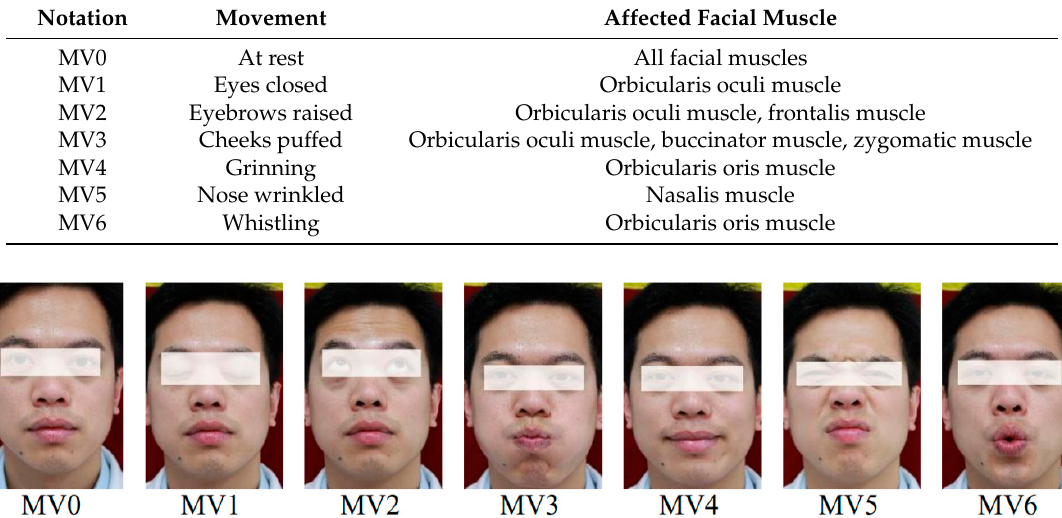
Figure 1. Facial images of the control subjects during seven movement types.